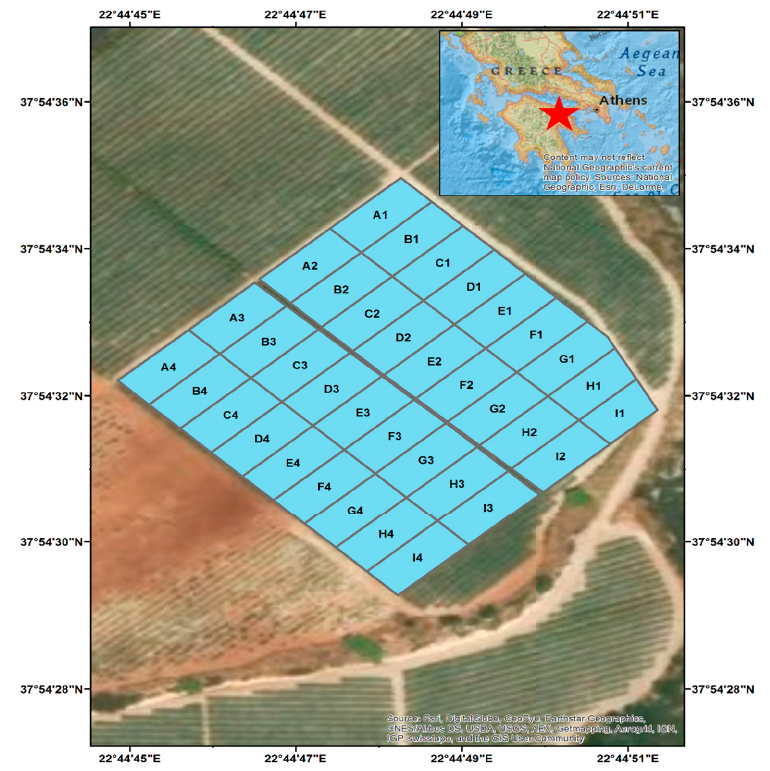
Figure 1. Satellite image of the table grapes in the commercial vineyard.